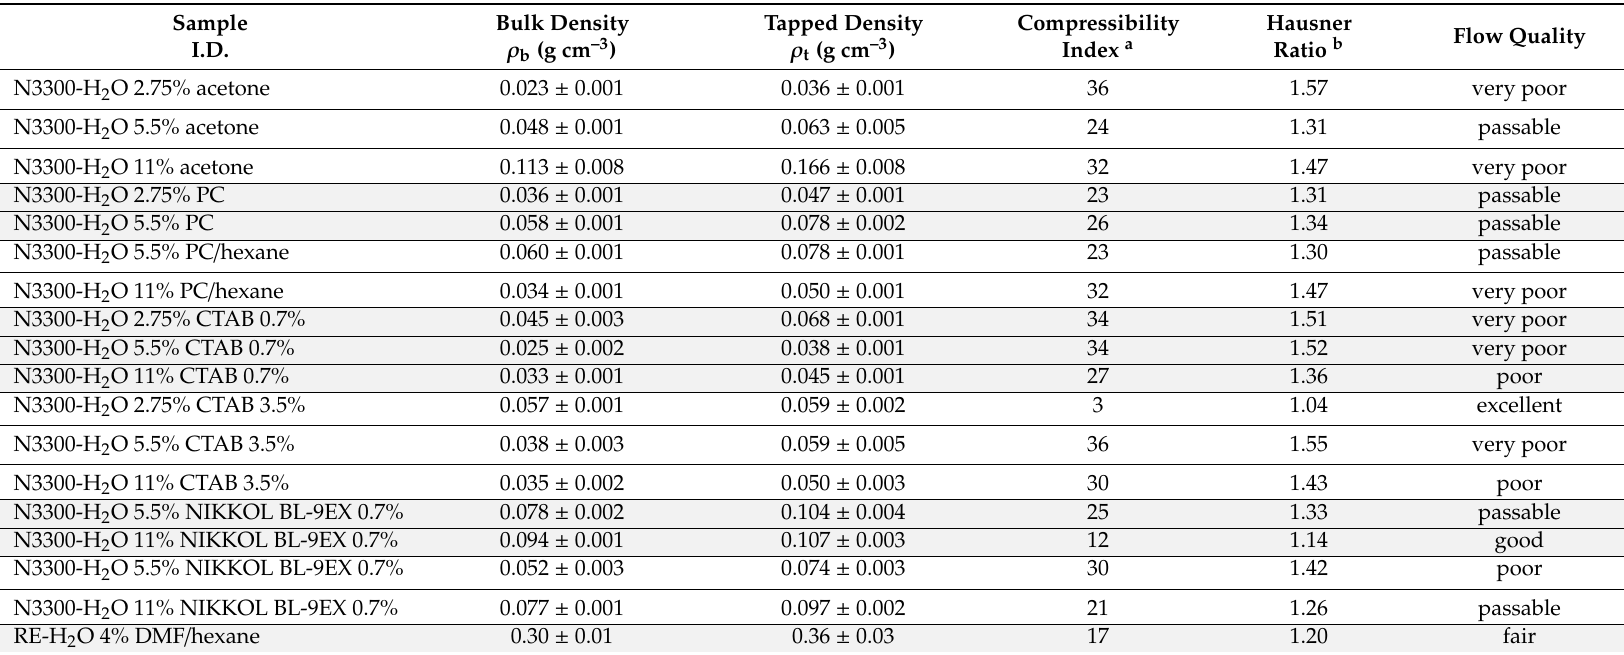
Table 2. Flow characteristics of particulate PUA